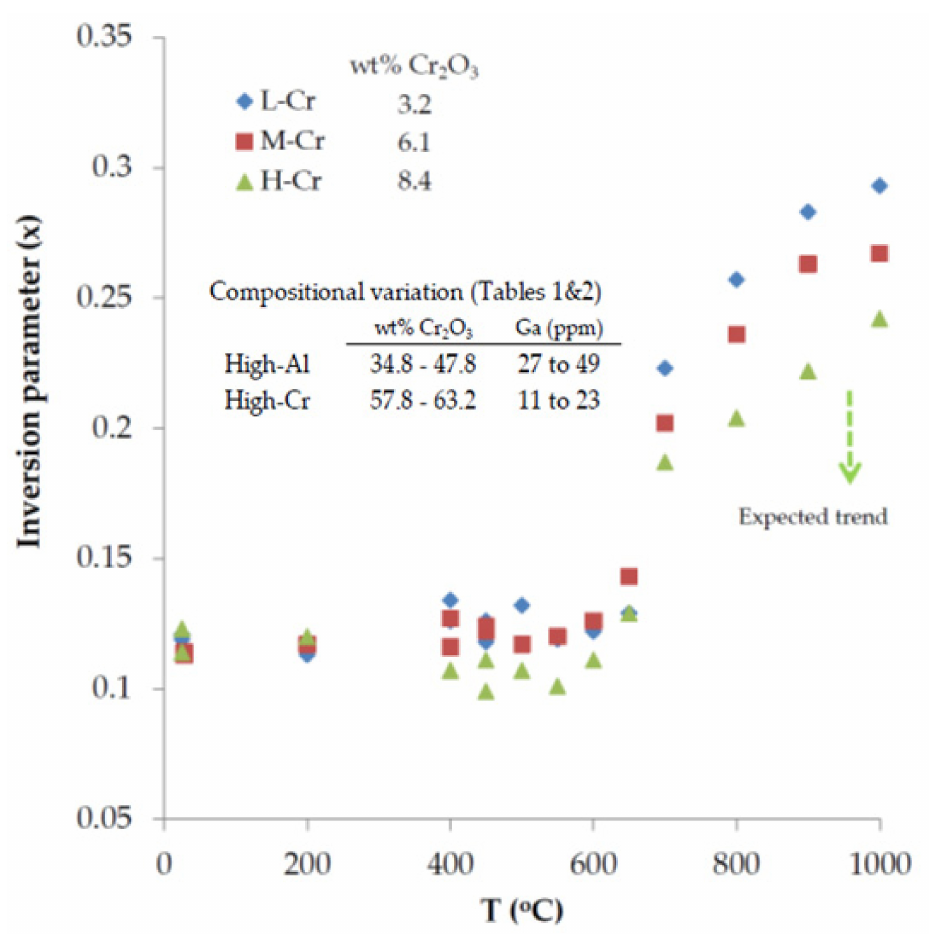
Figure 3. Plot of the Inversion parameter (x) versus temperature for spinels after [52]. A potential trend for chromitites with much higher Cr content (Table 1) is presented by the green